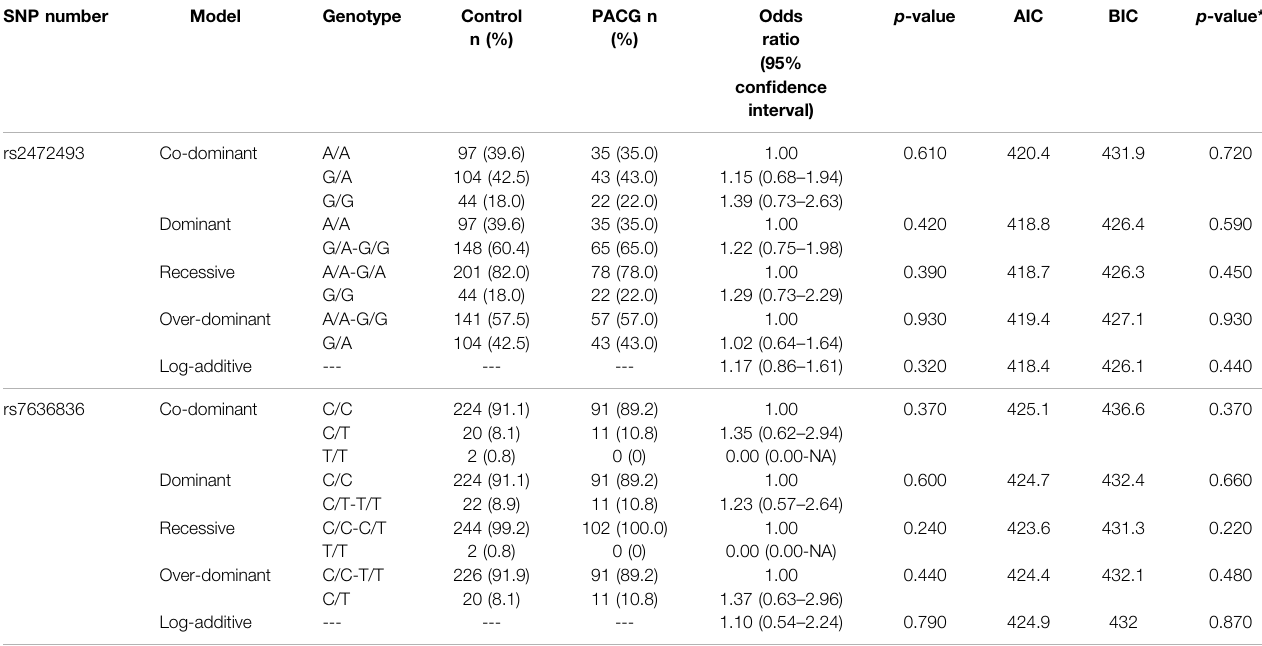
TABLE 2 | Association of rs2472493 ( ABCA1 ) and rs7636836 ( FNDC3B ) polymorphisms with the risk of primary angle-closure glaucoma compared to control under different genetic